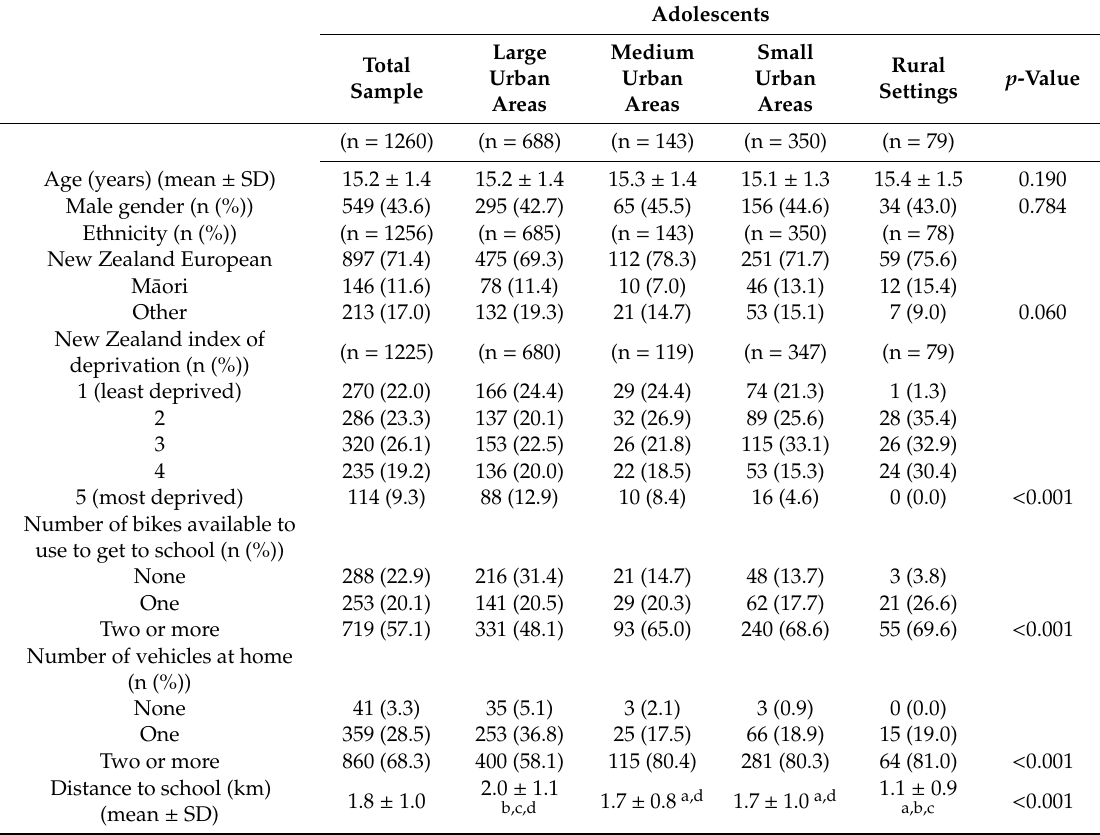
Table 2. Sociodemographic characteristics of adolescent